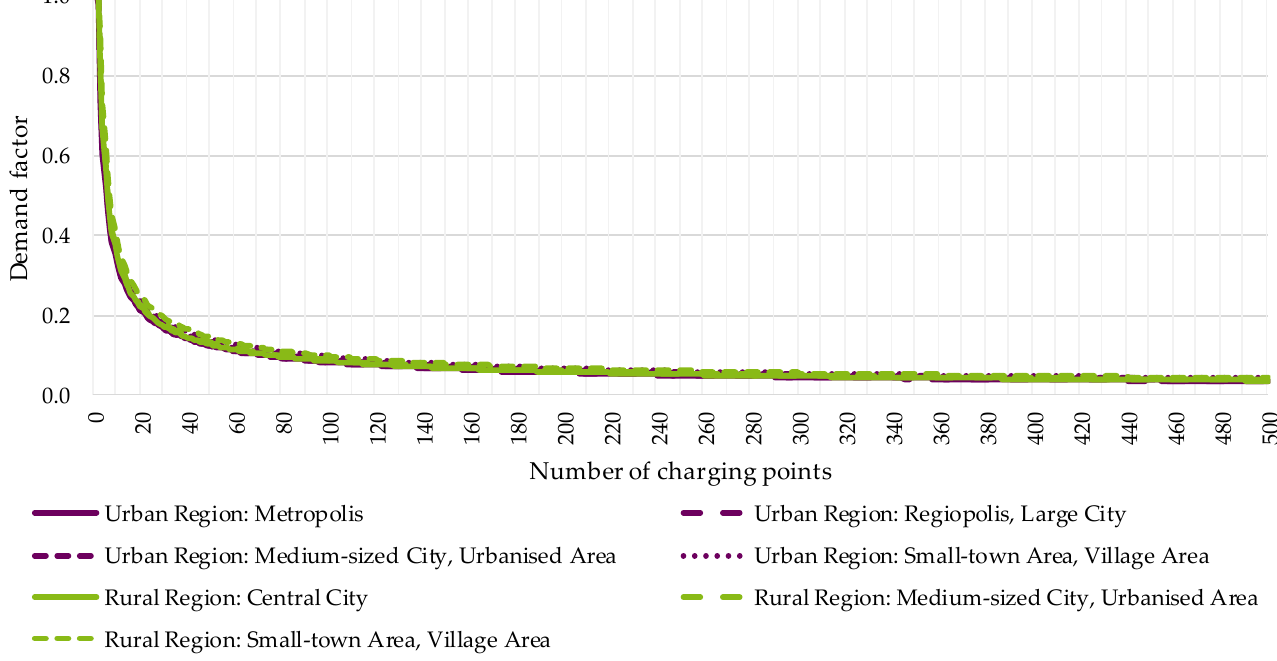
Figure 20. Demand factors (ordinate) for 50 kW charging power and seven different area types.